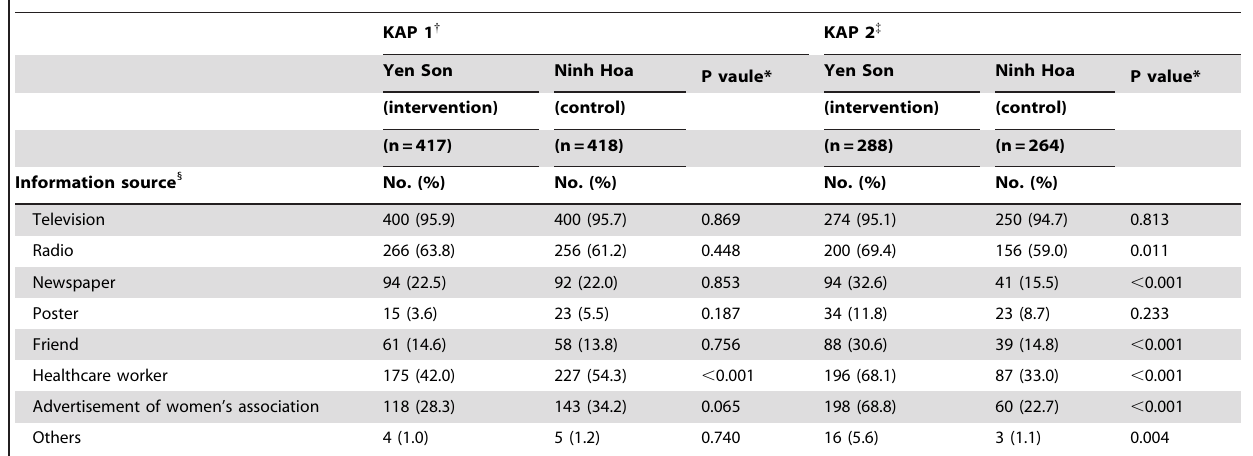
Table 2. Sources of avian influenza information.